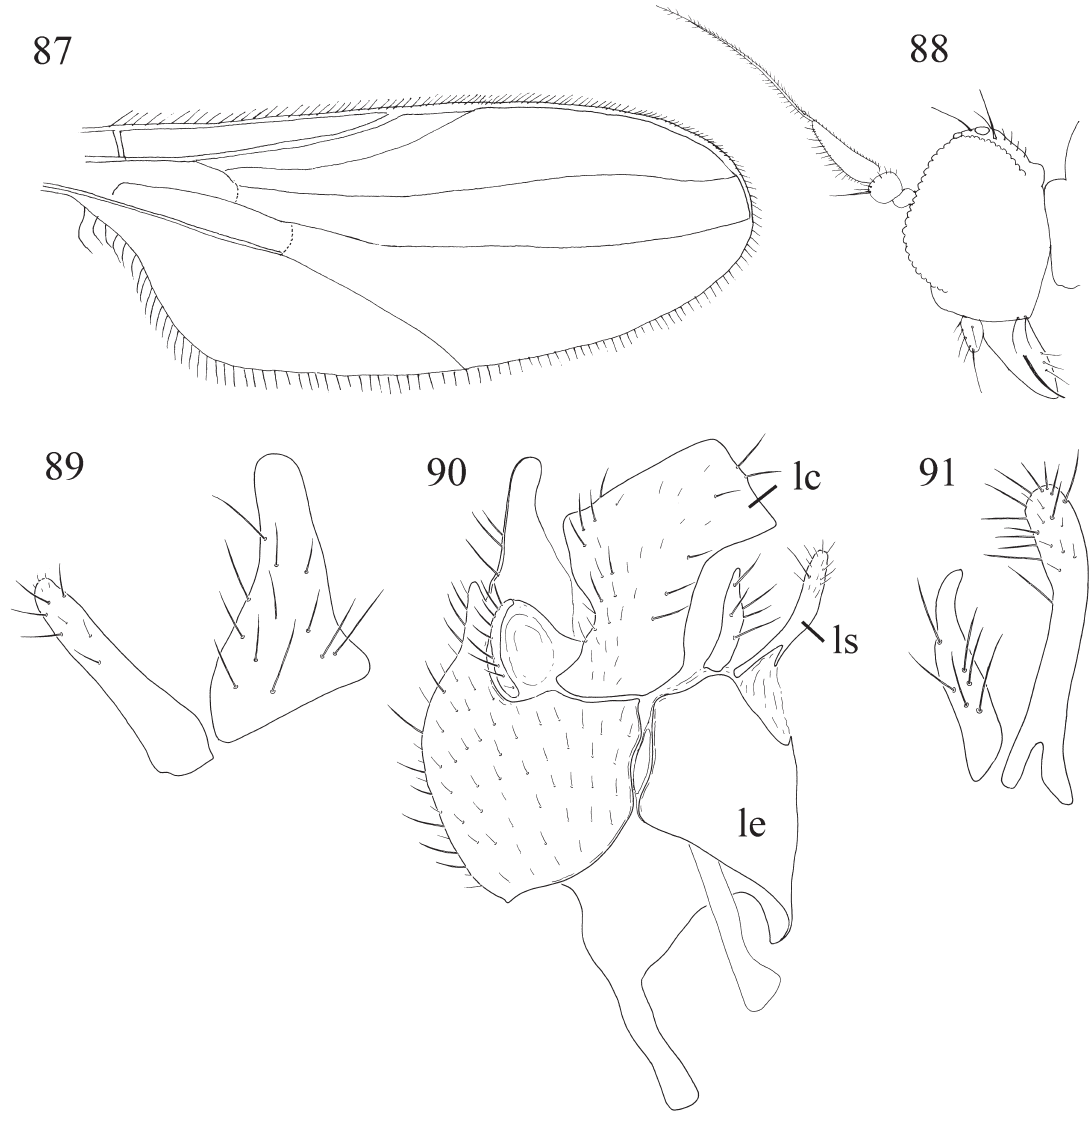
Figs 87-91. Drapetis bakau sp. nov., ♂. 87 . wing, dorsal view. 88 . head, lateral view. 89 . right surstylus, dorsal view. 90 . epandrium and cerci, dorsal view. 91 . left surstylus, lateral